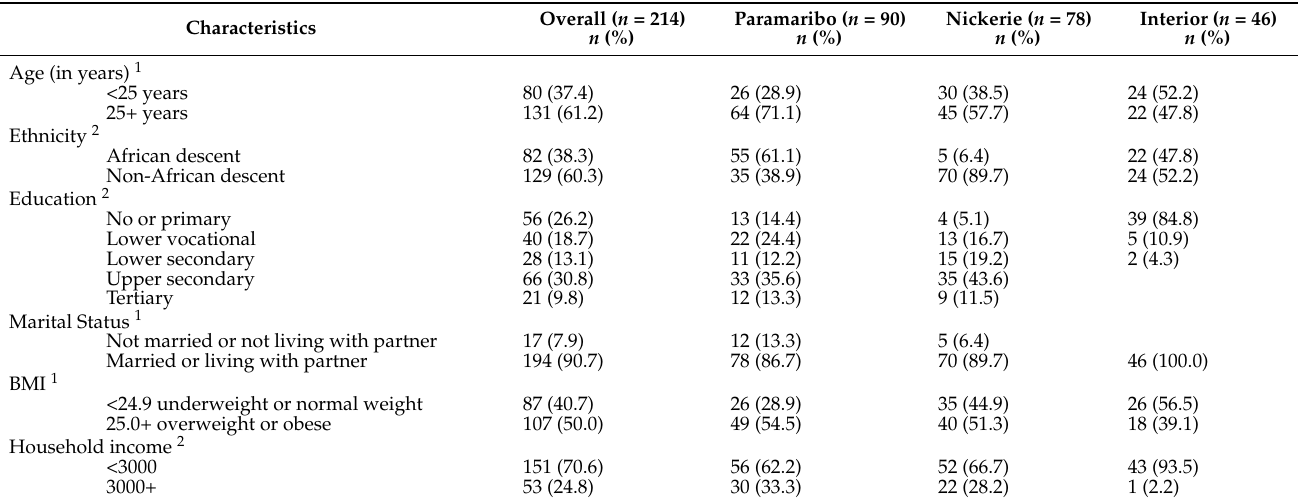
Table 2. Demographic characteristics of the pregnant women in Suriname, n =